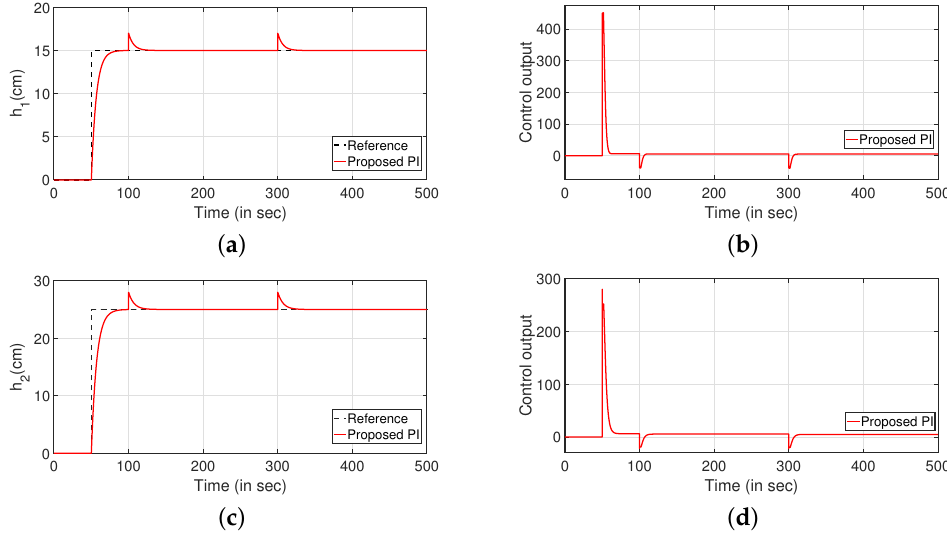
Figure 14. Servo response. ( a ) Level Variation in tank 1. ( b ) Control output. ( c ) Level Variation in tank 2. ( d ) Control output.